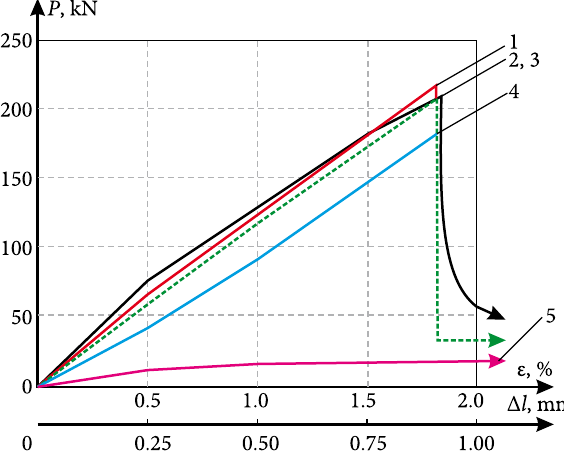
Fig. 4. Behaviour of hybrid composite cable: 1 – graph, which was obtained analytically for the composite material on the base of one CFRP tape and two steel tapes with taking into account two layers of epoxy glue with thickness in 1 mm; 2 – graph, which was obtained by the experiment for the composite material on the base of one CFRP tape and two steel tapes; 3 – graph, which was obtained analytically for the composite material on the base of one CFRP tape and two steel tapes. Two layers of epoxy glue with thickness in 1 mm were not taken into account; 4 – graph, which was obtained by the experiment for the CFRP tape; 5 – graph, which was obtained by the experiment with the steel tape. The results were obtained by the strain-measuring device with the length of 50 mm